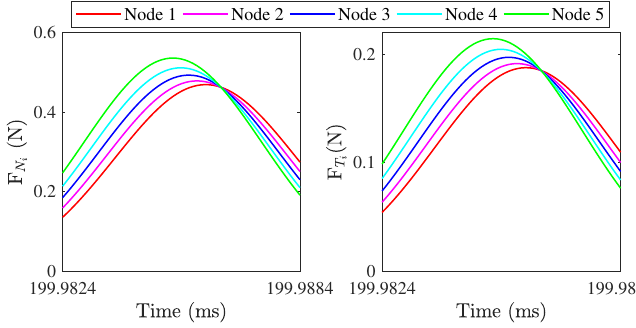
Figure 26. Partially enlarged view of the dashed area in Figure